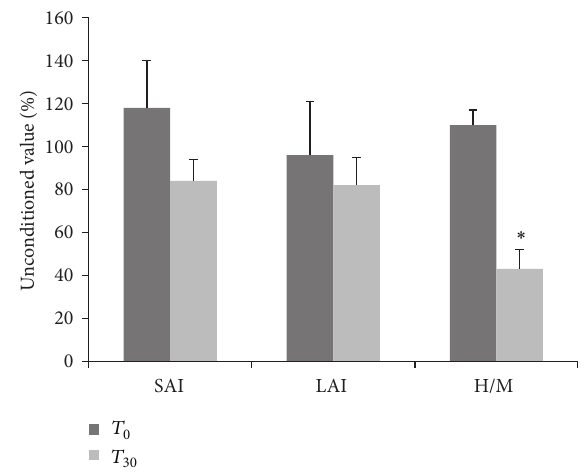
Figure 2: H max / M max ratio modification without any changes in SAI and LAI after one month of Sativex